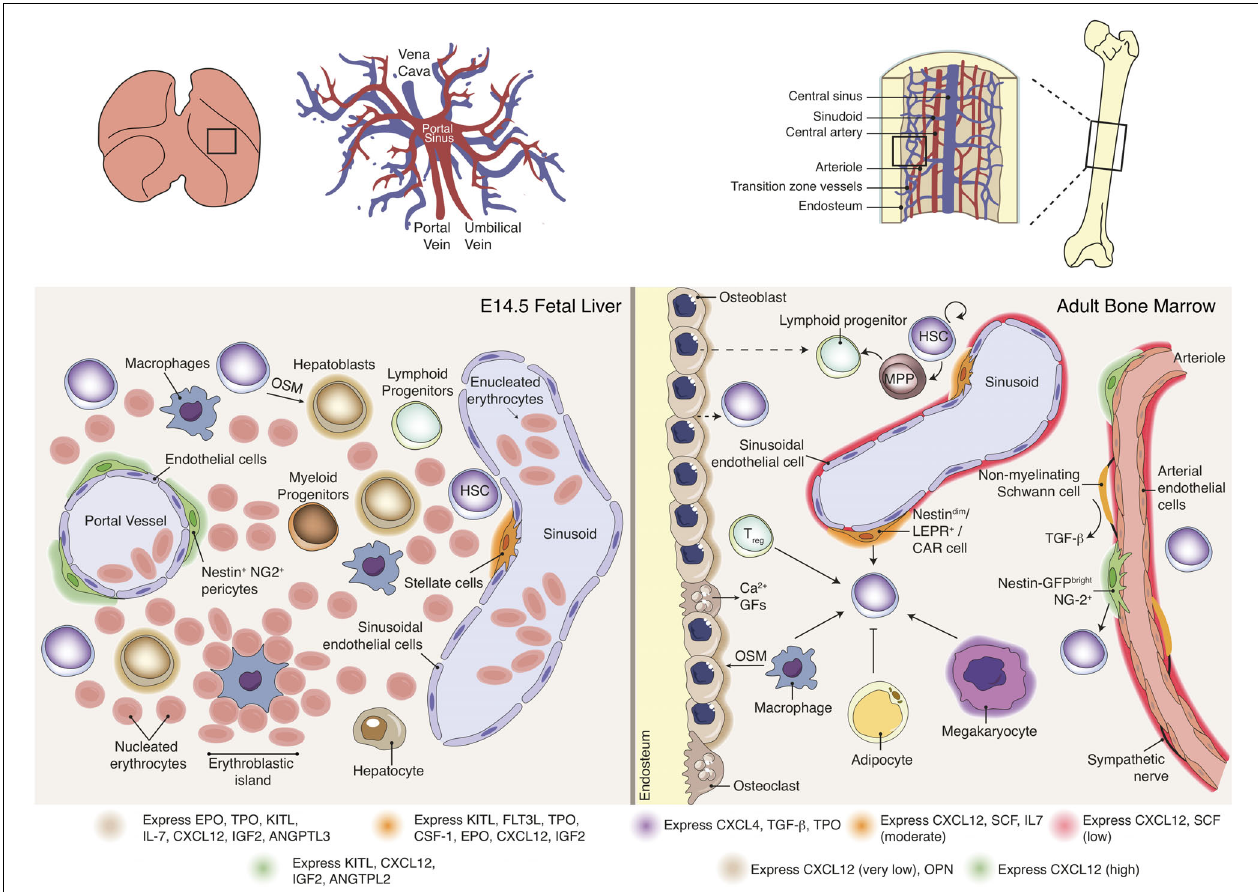
FIGURE 4 | Hematopoietic stem cell niche in fetal liver versus bone marrow. Distinct BM stromal cell populations have been described as modulators of HSC functions via expression of soluble and membrane-bound factors. Data available for FL stromal populations is scarce and consequently evidence for a direct role of stromal populations in HSC expansion or differentiation is not reported. The FL microenvironment includes cytokine-producing hepatoblasts, pericytes and stellate cells, together with high number of hematopoietic progenitors and distinct developmental stage erythroid cells. BM Nestin-GFP high , NG2 + perisinusoidal cells and Nestin-GFP dim , LepR + , CAR sinusoidal cells are key regulators of HSC maintenance, contributing differentially for cytokine production. Macrophages, T reg and megakaryocytes were also reported to contribute to HSC maintenance and mobilization. Sympathetic nerves regulate HSC mobilization through a tightly control of CXCL12 expression by stromal cells. Non-myelinating Schwann cells activate latent TGF- β into its active form, which may contribute for HSC maintenance. The role of osteoblasts in HSPC is still unclear. Adipocytes may negatively affect HSC